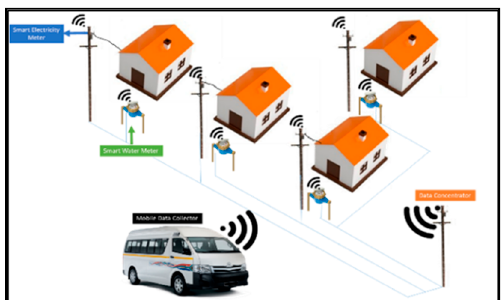
Figure 2. System Overview.